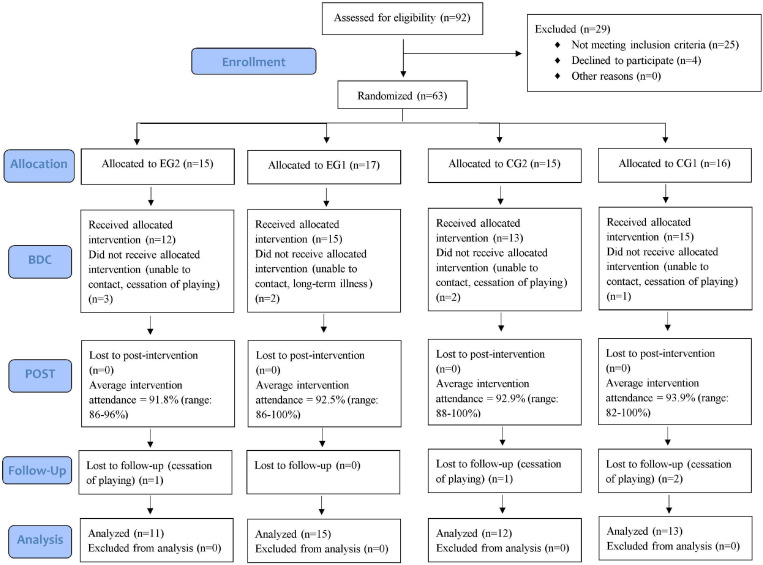
CONSORT flow diagram of study recruitment.